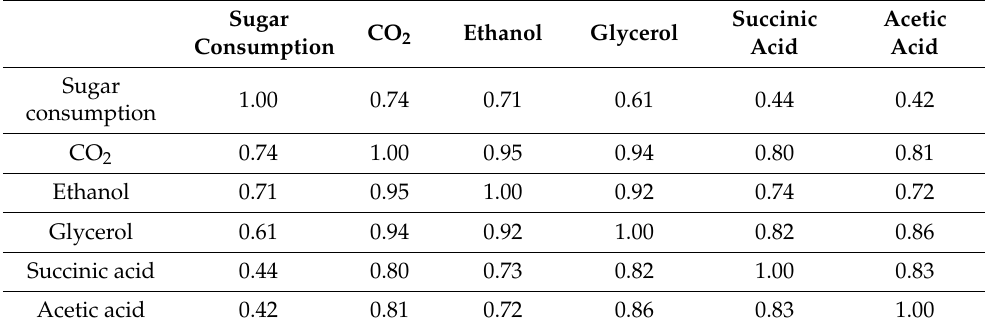
Figure 3. Correlation between the sum of the CO 2 production and the measured ethanol, glycerol, and organic acid concentrations in sweet doughs (14% sugar, w / w dm flour). Vertical bars represent standard deviations of triplicate metabolite measurements and horizontal bars represent standard deviations of triplicate consumption measurements. Table 3. Correlation matrix of sugar consumption, CO 2 production and ethanol, glycerol, succinic acid, and acetic acid concentrations in sweet dough (14% sucrose w / w dm flour) with 23 different yeast strains, resulting from performing the multivariate correlation test with correlation probabilities p < 0.001 for all